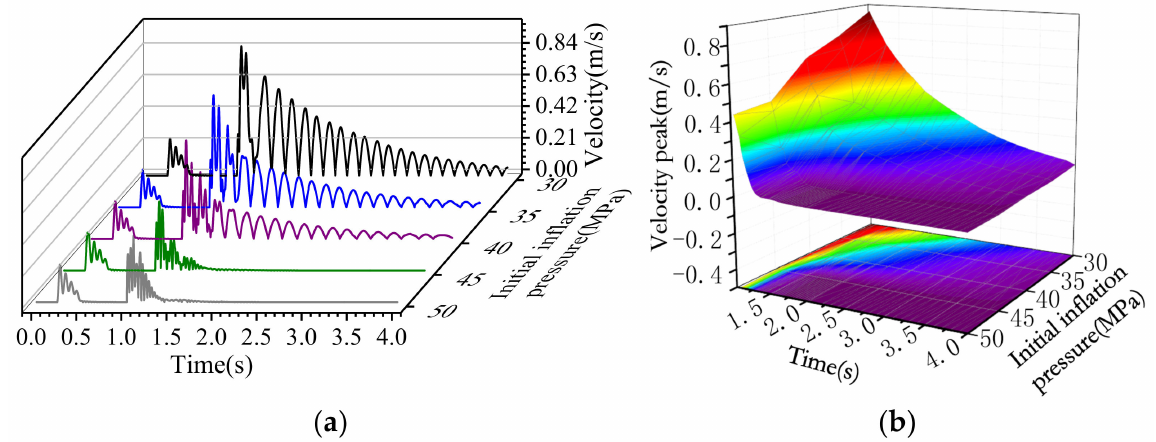
Figure 10. ( a ) Speed comparison of piston rod. ( b ) Peak fitting of velocity